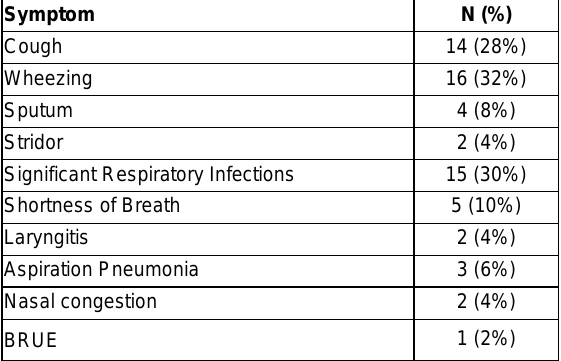
Table I: Illustrates the frequency of common respiratory symp- toms in patients with EA/TEF Symptom